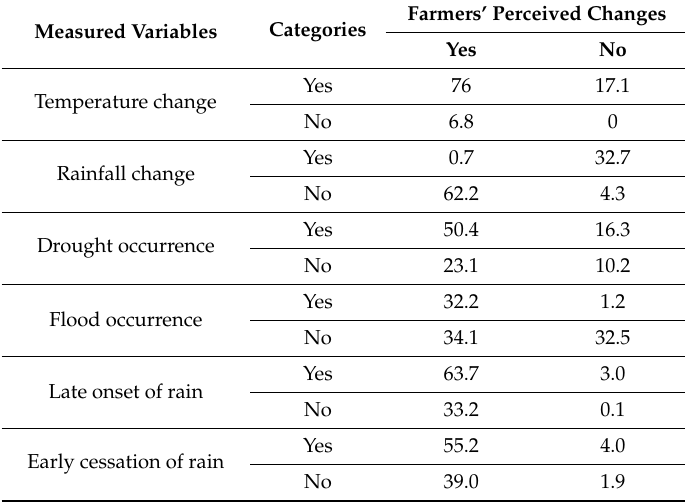
Table 6. Percentage distribution of variation of farmers’ perceptions of climate change and variability by observed meteorological results (n = 810).